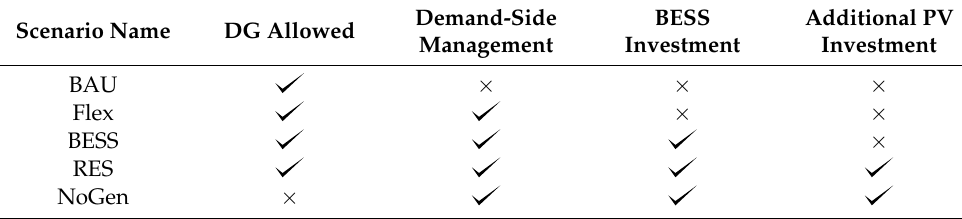
Table 4. Summary of scenarios per diesel